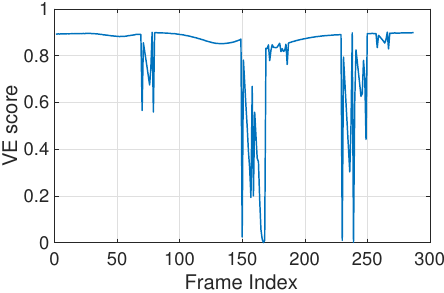
Figure 11. Example of the VE score of a FPV.